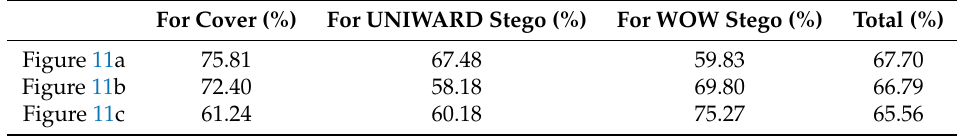
Table 5. Ternary classification rates of deeper networks in Figure 11 ( bpp =